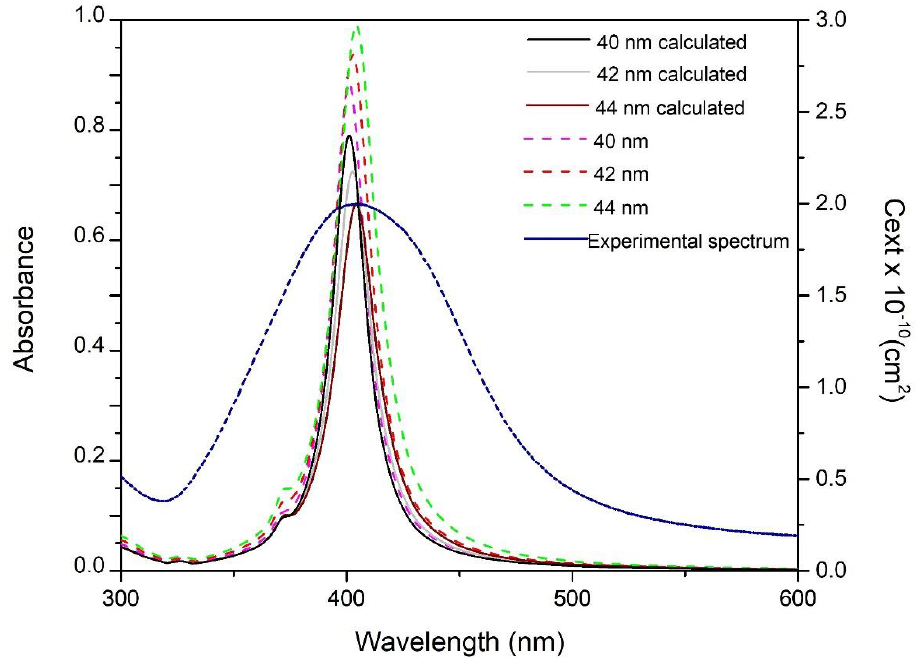
Figure 12. Theoretical obtained spectra for AgNPs with diameters from 40–46 nm, and the Figure 11. Theoretical obtained spectra for AgNPs with diameters from 40–46 nm, and the experi- experimentally obtained spectrum. mentally obtained The dark-colored lines (light grey, black, and brown) are the theoretical calculated spectra, while the dotted ones represent the extinction cross-section spectrum.